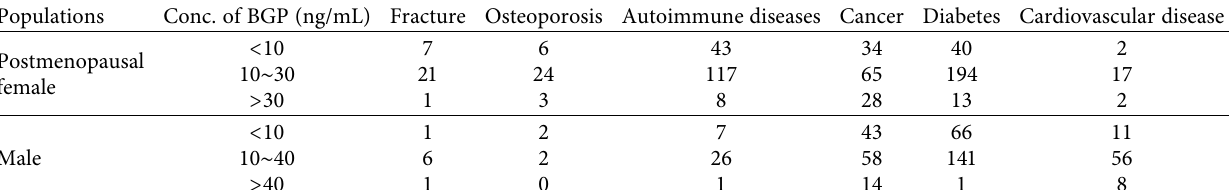
Table 6: Distribution of clinical samples.